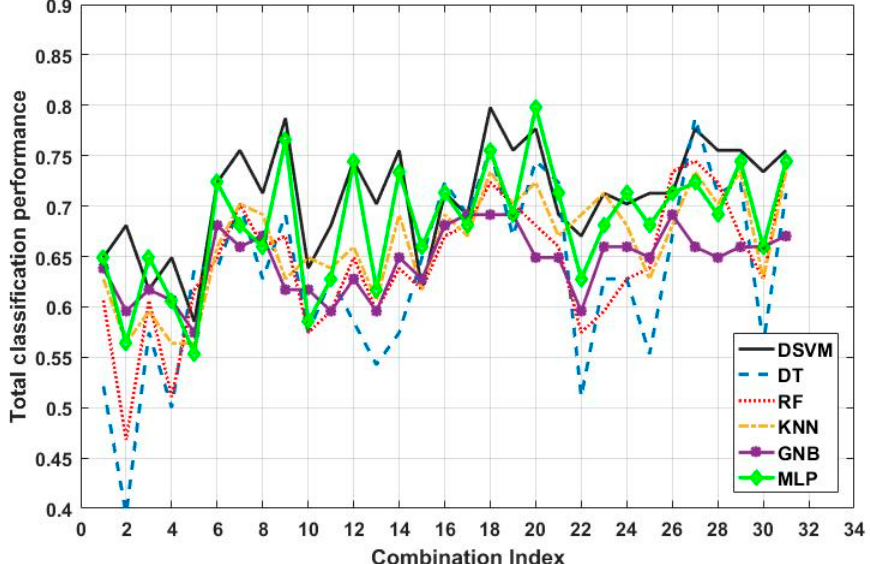
Figure 9. Total classification accuracy versus combination index for classifying wood and plastic for different classification approaches using LOO cross-validation.